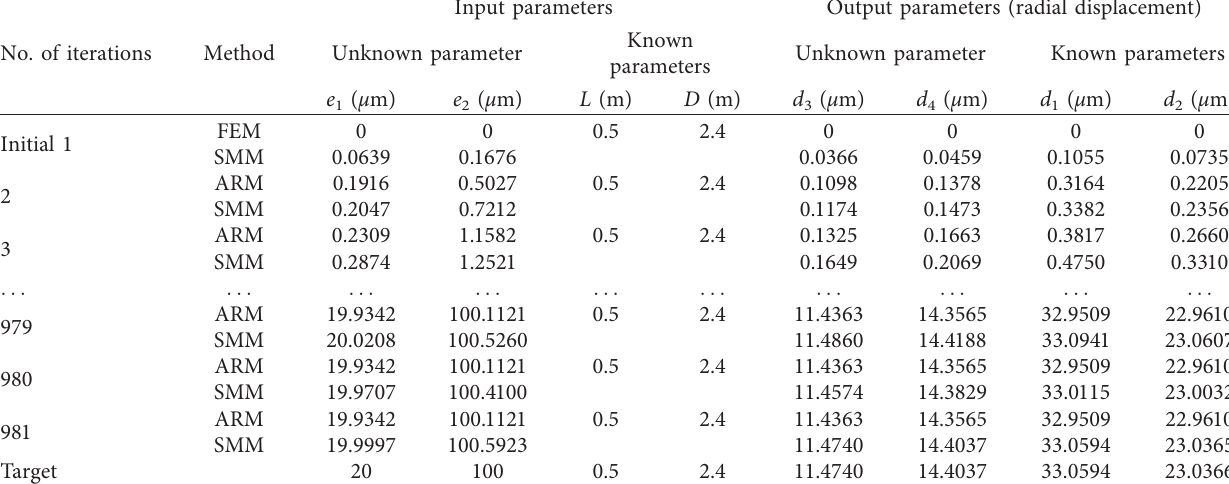
Table 2: Eccentricity parameter identification procedure using improved maximum likelihood